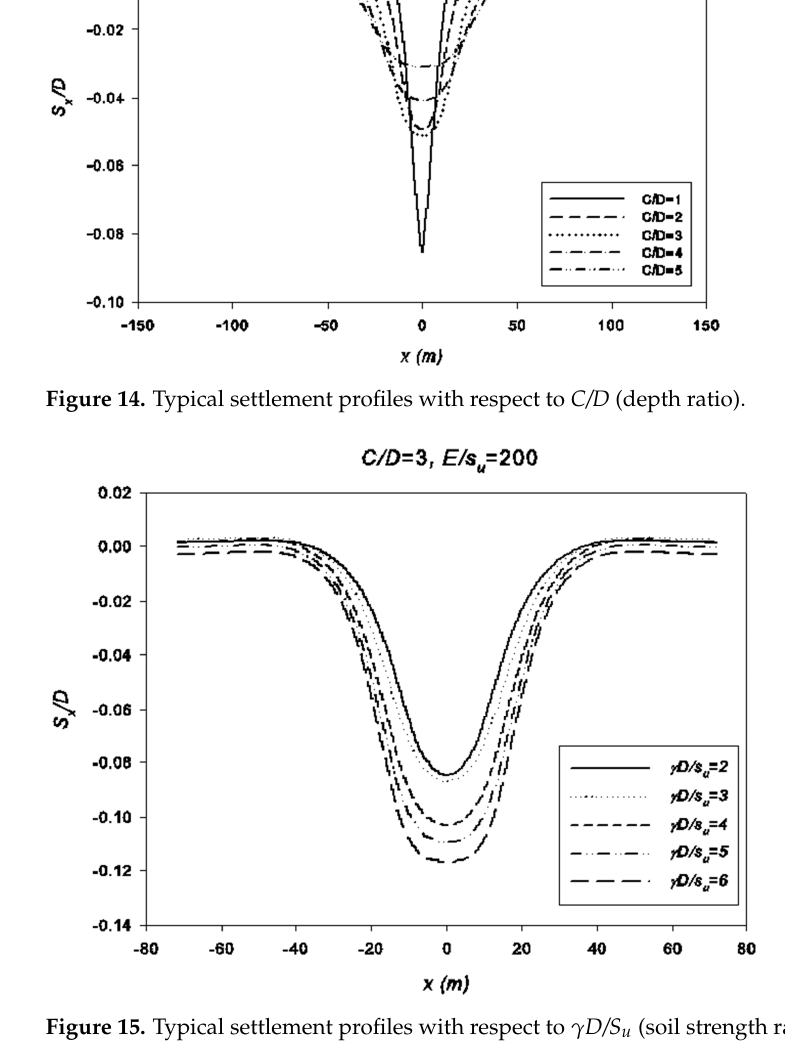
Figure 15. Typical settlement profiles with respect to γ D/S u (soil strength ratio).